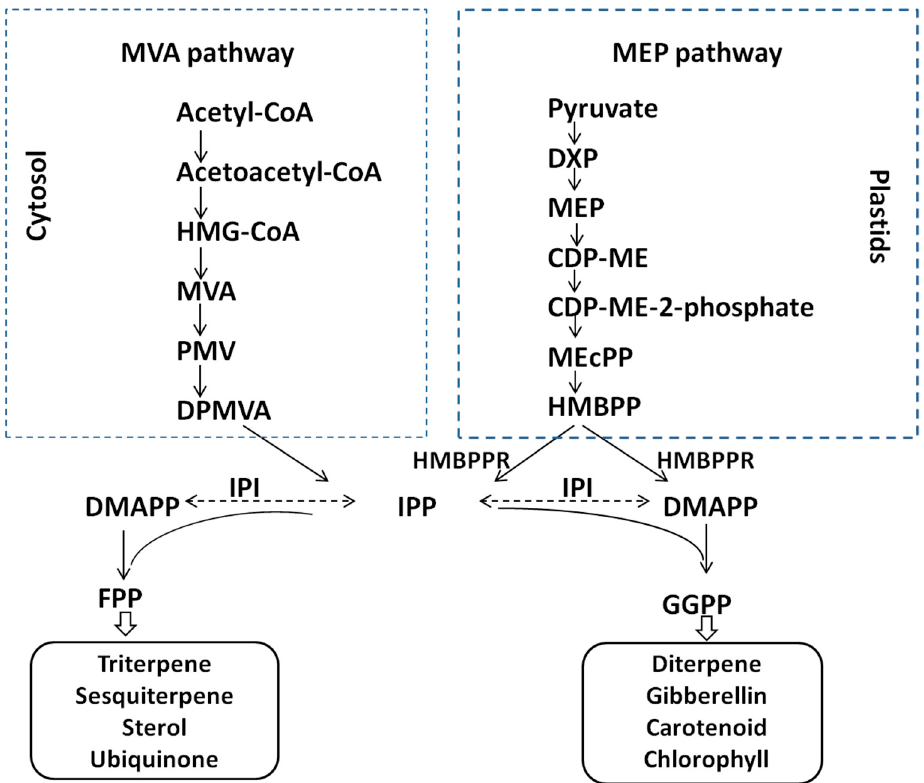
Figure 1. IPP and DMAPP synthesis pathway in plants. DMAPP is converted from IPP by IPI in the MVA pathway, whereas the simultaneous production of IPP and DMAPP from HMBPP occurs in the MEP pathway. HMG-CoA, 3-hydroxy-3-methylglutaryl CoA; MVA, mevalonic acid; IPP, isopentenyl diphosphate; DMAPP, dimethylallyl diphosphate; FPP, farnesyl diphosphate; GAP, glyceraldehyde 3-phosphate; DXP, 1-deoxy-d-xylulose-5-phosphate; MEP, 2-C-methyl-d-erythritol 4-phosphate; HMBPP, 1-hydroxy-2-methyl-2-( E )-butenyl 4-diphosphate; HMBPPR, 1-hydroxy-2-methyl-2-( E )- butenyl-4-phosphate reductase; GGPP, geranylgeranyl diphosphate.